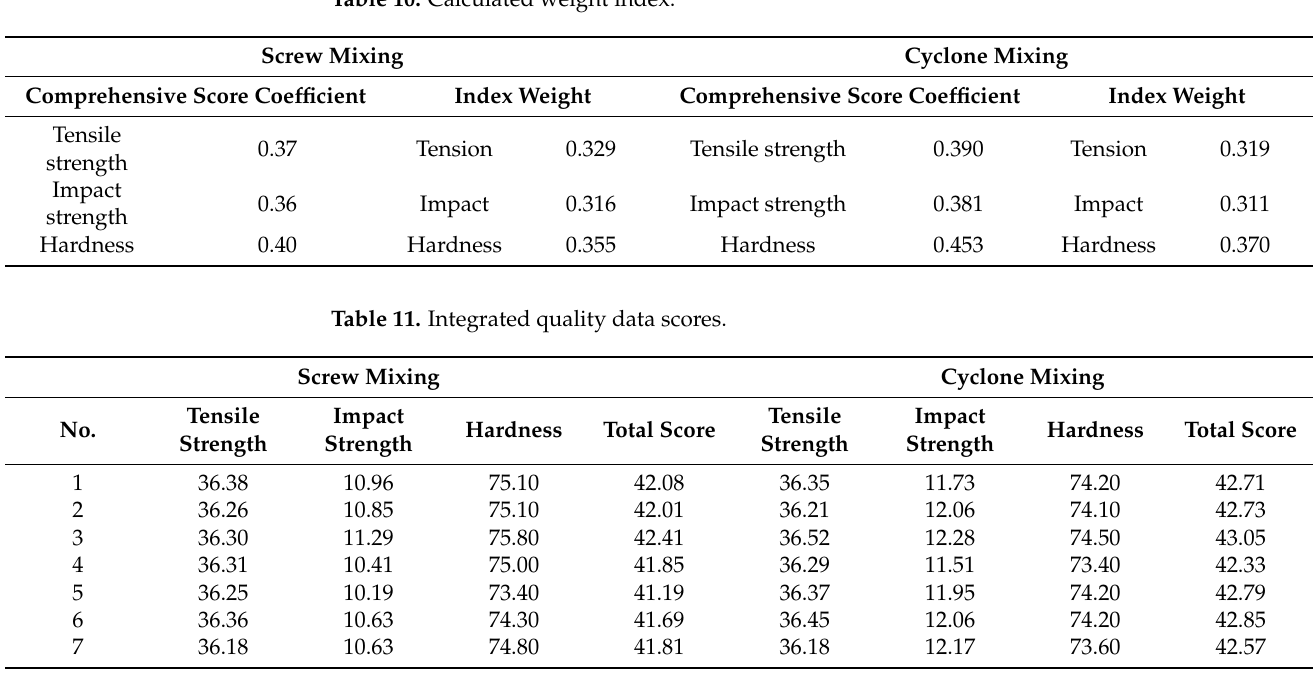
Table 10. Calculated weight index.